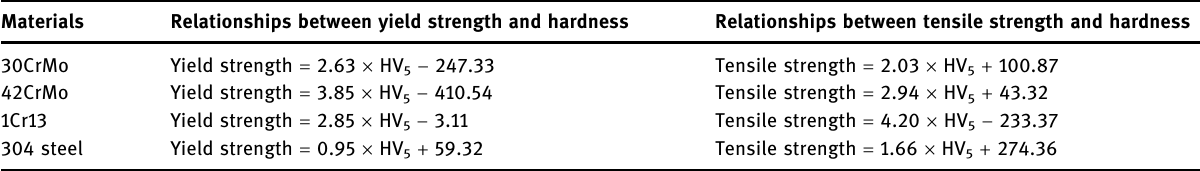
Table 3: Relationships between strength and hardness of 30CrMo, 42CrMo, 1Cr13, and 304 steels Materials Relationships between yield strength and hardness Relationships between tensile strength and